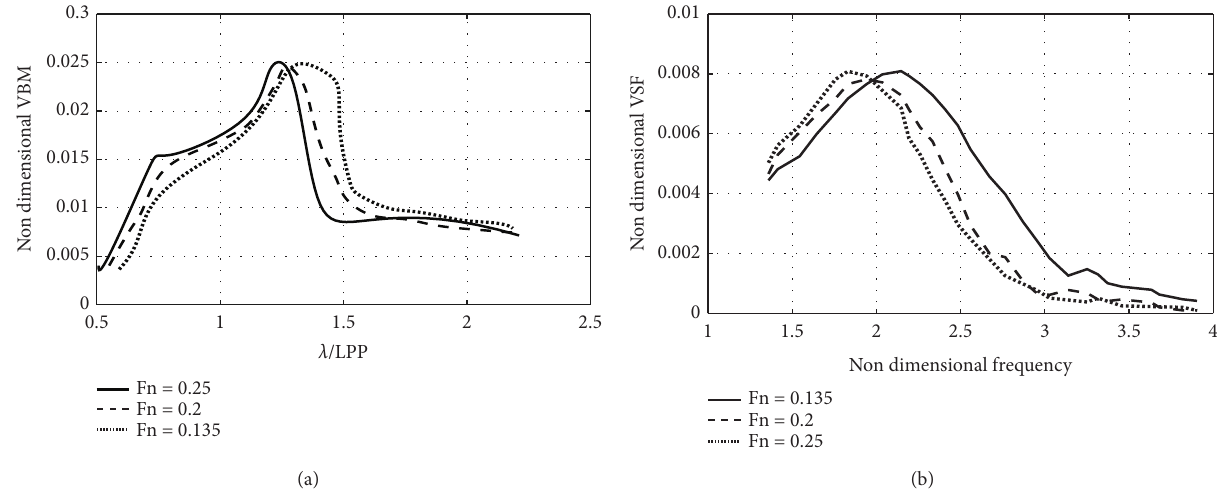
Figure 12: (a) Transfer function for VBM at amidships for different forward speeds of S175. (b) Transfer function for VSF at amidships for different forward speeds of S175.